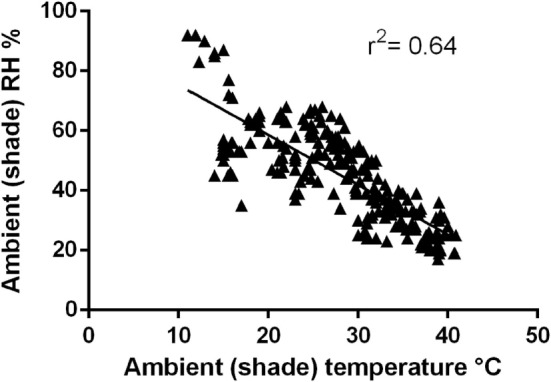
Relationship between ambient temperature and relative humidity recorded at racetracks (r2 = 0.64, p = 0.0001).